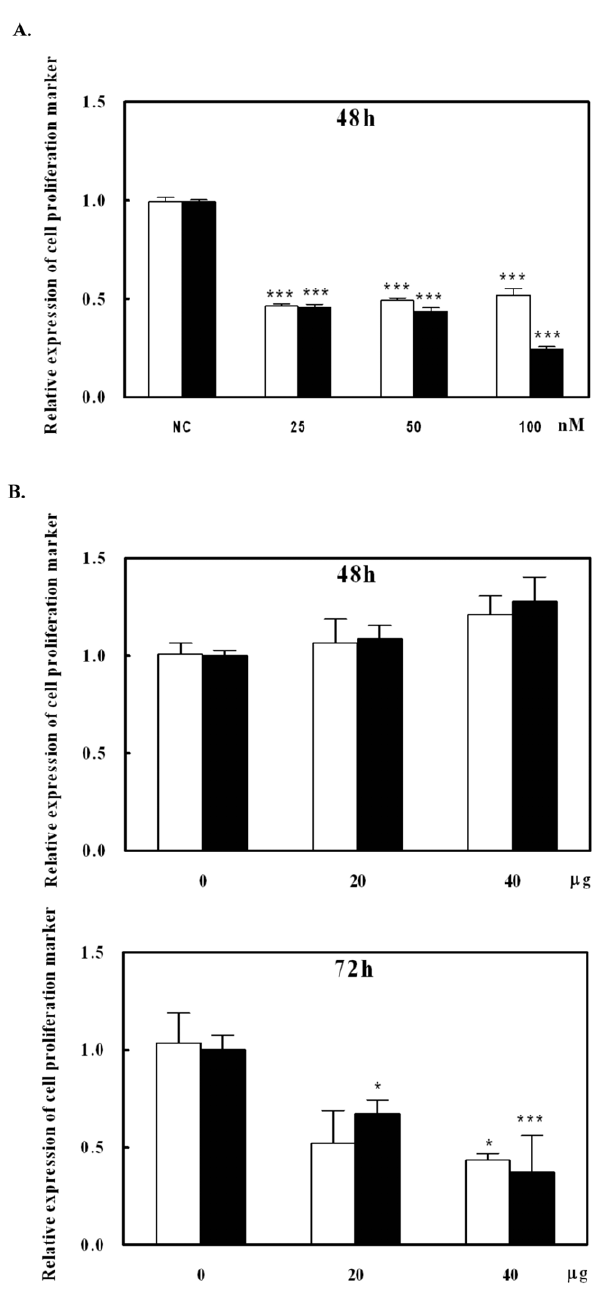
Figure 7. Effect of NGAL on cell growth invitro . Using AsPC-1 cells as a testing cell line, Ki-67 (white bars) and TPX2 (black bars) gene expression levels were measured. (A) After miR-138 transfection to AsPC-1 cells for 48 h, total RNA was collected and two gene expressions were measured. (B) After NGAL antibody supplement for 48 and 72 h to the cultured cells, total RNA was collected and two gene expressions were measured. * and *** indicate p , 0.5 and p , 0.001, respectively. doi:10.1371/journal.pone.0052979.g007 138 low expression levels in AsPC-1, RL95-2 and OVCAR-3 cells, whereas the reverse was the case for MCF-7 and HeLa cells. MiR-138, NGAL mRNA and protein levels were measured in the three cell lines: MCF-7, AsPC-1 and RL95-2. NGAL mRNA levels were high in AsPC-1 and RL95-2 cells compared to MCF-7 cells (Fig. 2A). Levels of the intracellular and, to a lesser extent, the